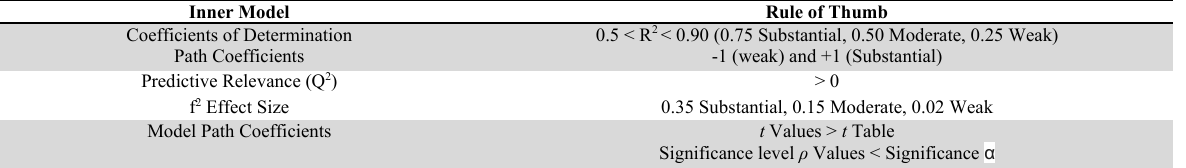
Rule of Thumbs, Structural